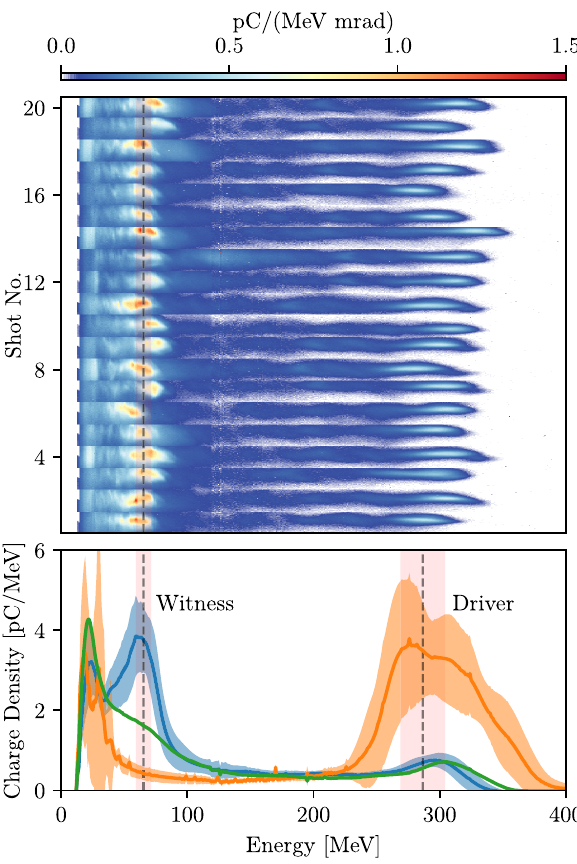
FIG. 2. Experimental data on stable plasma wakefield acce- leration. Top: output spectra of 20 consecutive shots with the HOFI-generated shock and preionized plasma in the second jet. Bottom: electron spectra with injector laser beam (blue). This is compared to spectra without plasma (orange) and with plasma, but no injector (green) in the PWFA stage. The strong charge and energy loss of the driver in the green case and the injection of a high-charge witness in the blue case are evident. Dashed lines and red shaded areas indicate the mean of the energy and its standard deviation of driver and witness bunches, respectively. For reference, angle-resolved spectra of the drive beam alone and after the PWFA stage but without injector can be found in Fig.